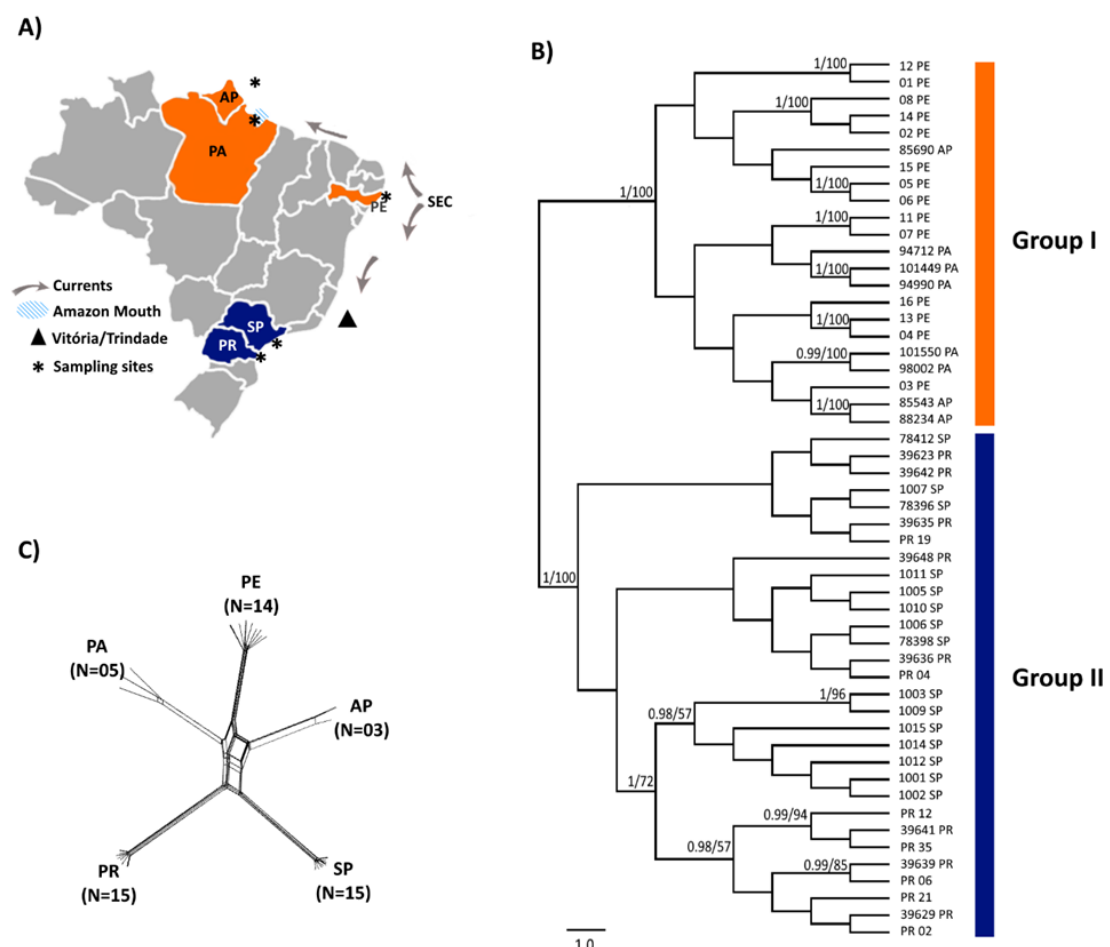
Figure 4. ( A ) Map of the analyzed Pseudobatos percellens Brazilian coast sampling sites, highlighted along the Southern Equatorial Current (SEC), region of the mouth of the Amazon River, and Victoria-Trindade Seamount Chain. ( B ) Phylogenetic tree based on Bayesian Inference with 1.448 SNPS identified in P. percellens , and posterior probabilities ( ≥ 0.98) and Bootstrap values ( ≥ 57) obtained from the Maximum Likelihood Analysis employing the same matrix. ( C ) NeighborNet splits based on the uncorrected p-distance with the groups identified in the samples AP, Amapá; PA, Pará; PE, Pernambuco; SP, São Paulo; PR, Paraná.